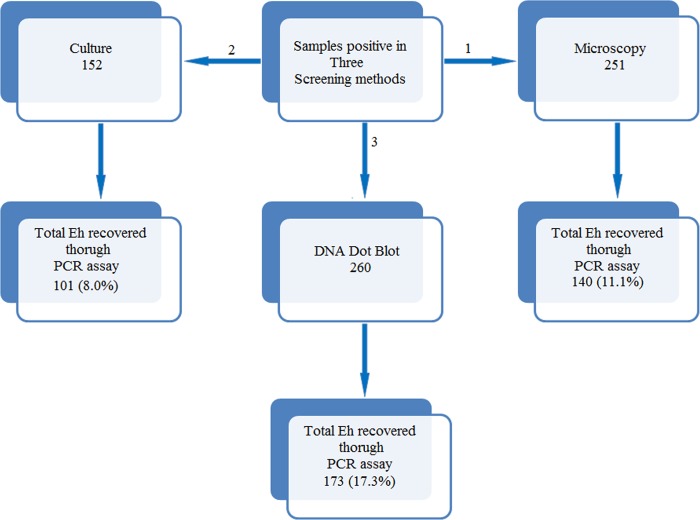
Screening protocol for Entamoeba positive stool samples using different screening techniques.Numbers in each box represent positive samples obtained by each method out of total 1260 stool samples. The DNA Dot blot was carried out using a probe that hybridizes with E.h and /or E.d positive DNA samples.